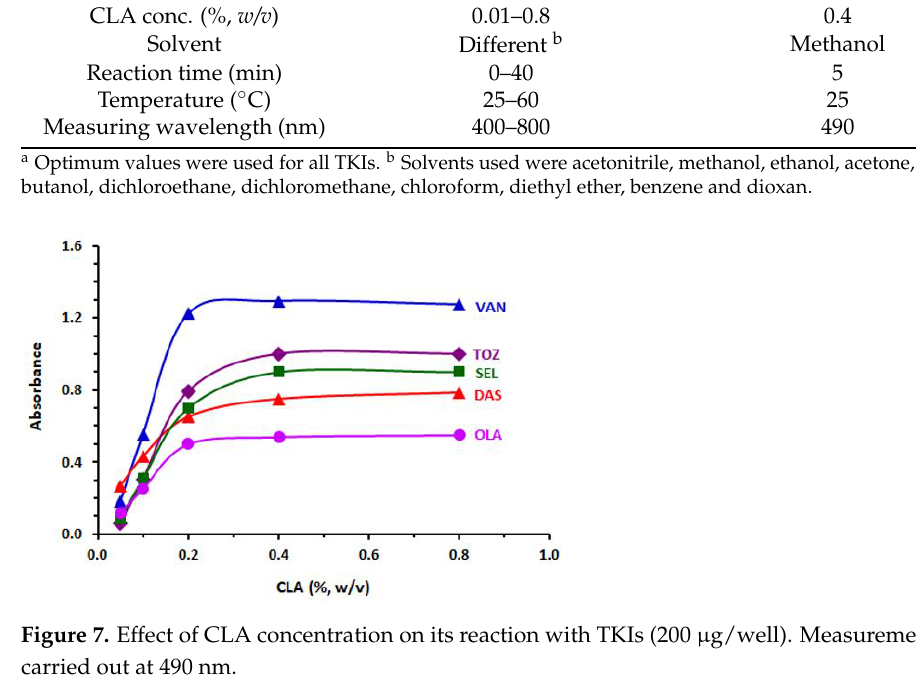
Table 4. Optimization of experimental conditions for the 96-microwell spectrophotometric assay for TKIs based on their CT reaction with CLA.